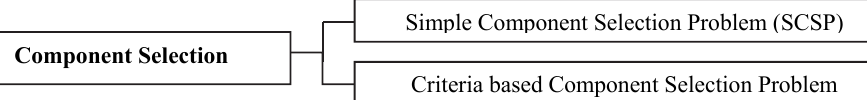
Fig. 1. Classification of the problem of component